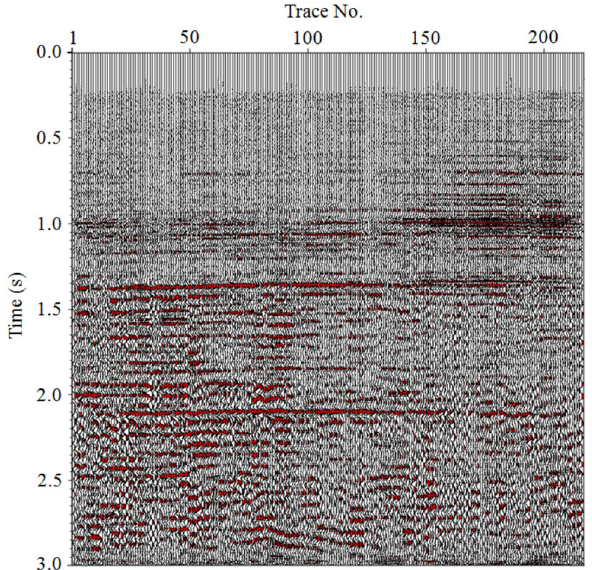
Fig. 17 Reflection signals separated from Fig. 14 using the presented denoising method. The uncorrelated background noise level has been reduced and trace-to-trace coherency thus enhanced